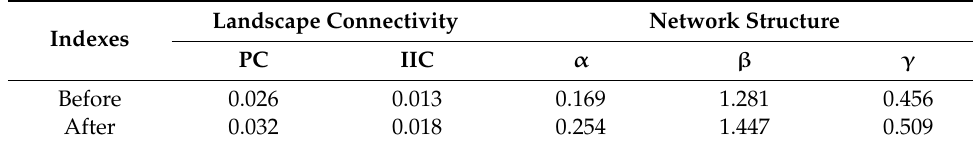
Table 9. Evaluation indexes before and after the ESP optimization.